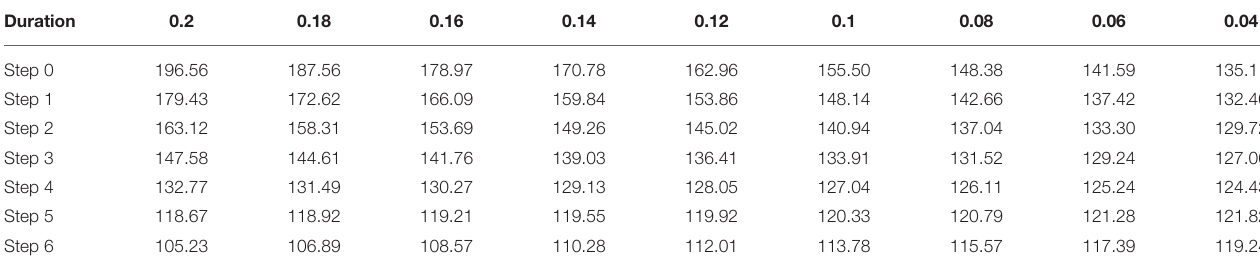
TABLE 2 | Onset values for each step varied by duration for linear rising pitch directions. Duration